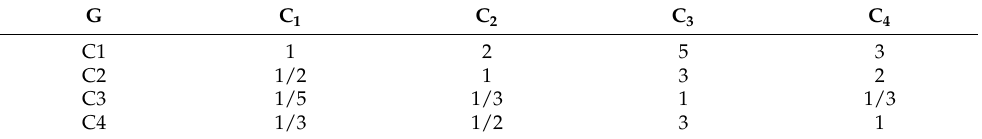
Table 6. Scale values table of mixing augmentation